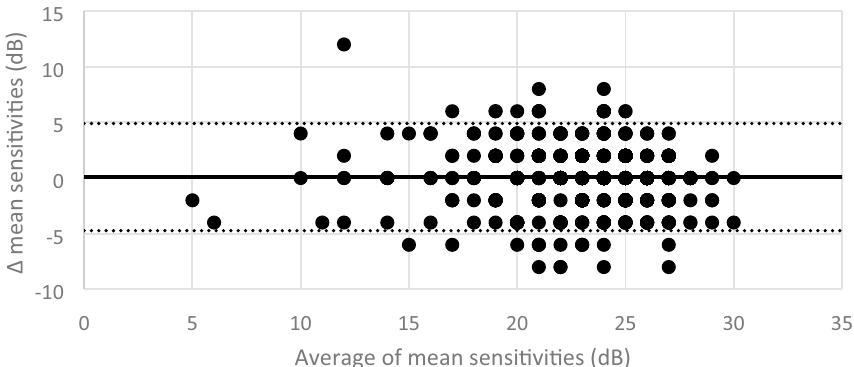
Figure 4. Bland–Altman plots for the sensitivity threshold of all individual tested grid points in 2 successive mesopic microperimetry tests when all grid points were included for the complete cohort. The x-axis shows the mean sensitivity for each point in the pair of repeated tests for each subject, the y-axis the difference between the average sensitivity in the two tests. The overall mean difference is represented by the central bold line, and the 95% limits of agreement are marked by the upper and lower dashed